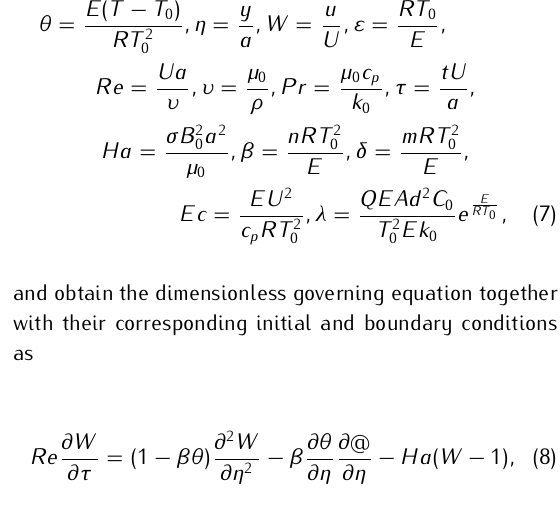
the induced magnetic field and the Hall effects of MHD are negligible. The fluid chemical species may undergo exothermic oxidation/reduction reaction with Arrhenius ki- netic (without reactant consumption) leading to additional internal heat generation within the